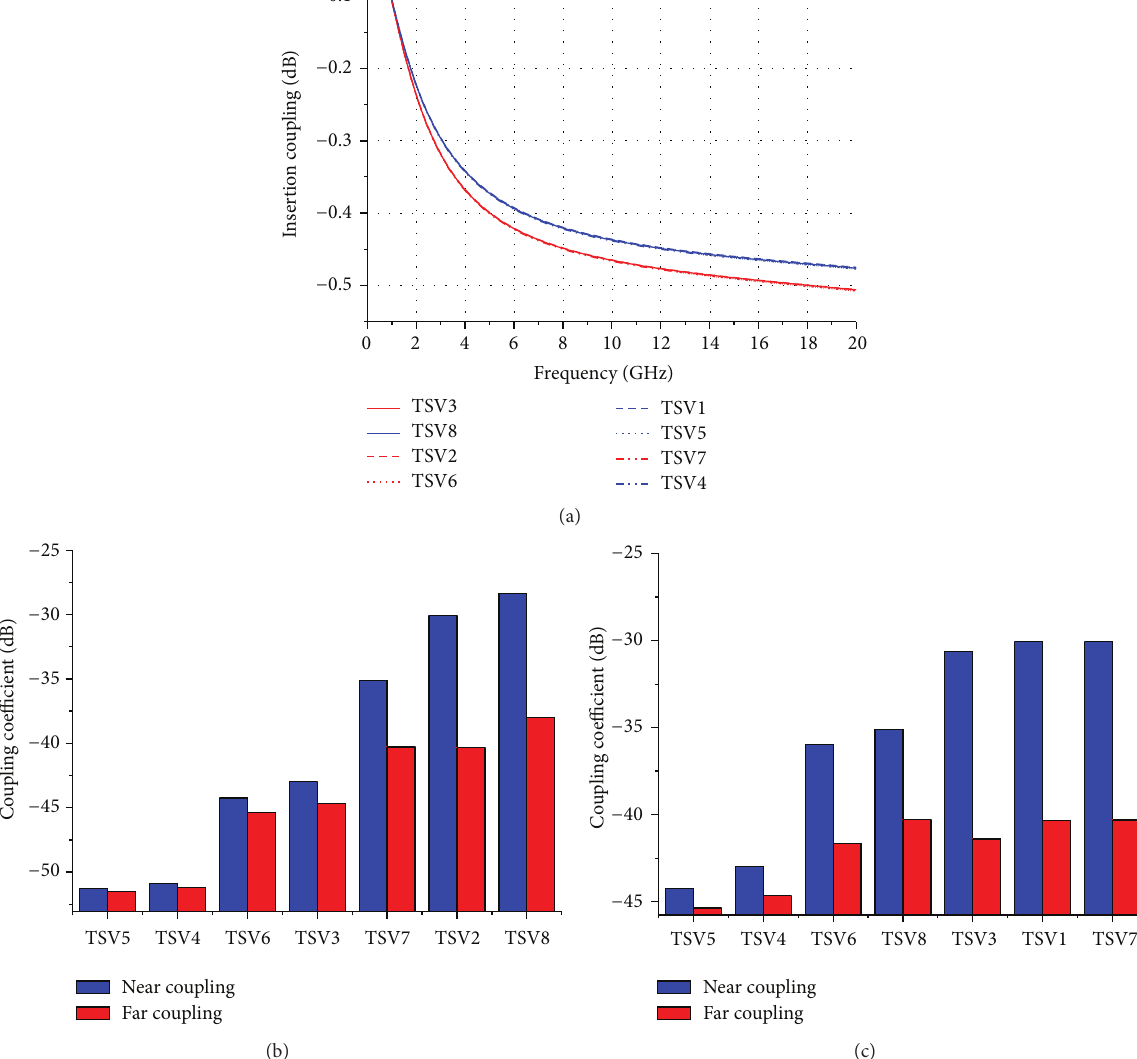
Figure 15: 𝑆 parameters result of Model 2. (a) Insertion loss of each TSV, (b) the cross talk from the aggressive TSV to TSV1 at 20 GHz, and (c) the cross talk from the aggressive TSV to TSV2 at 20